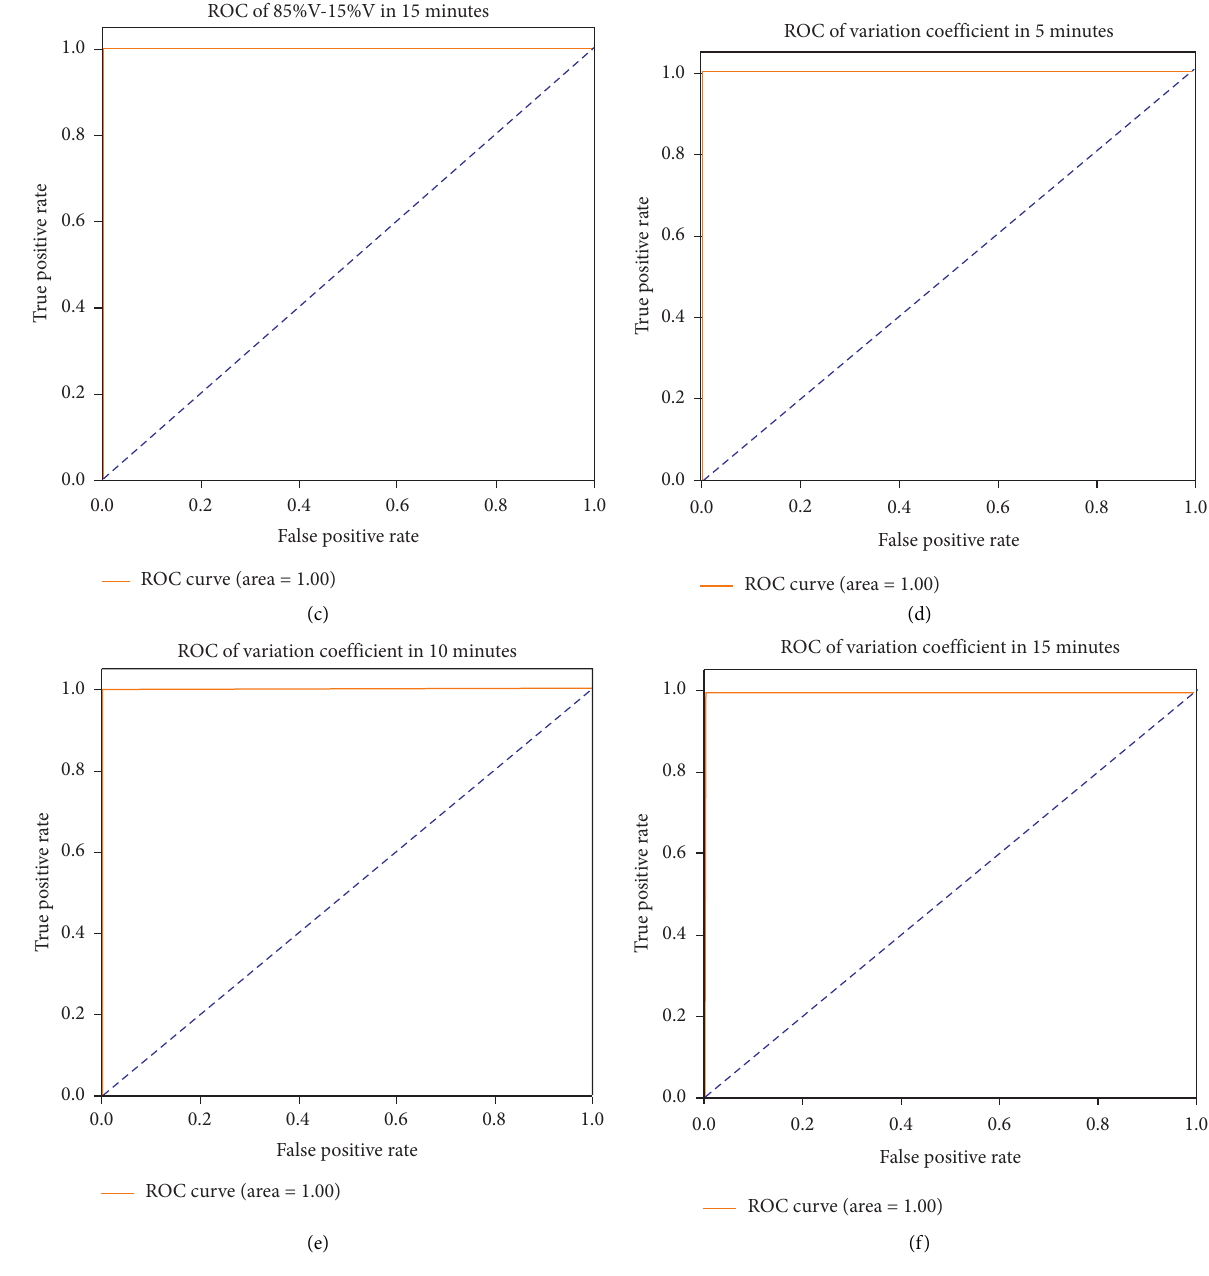
Figure 6: The ROC curve for SVM of 85%V–15%V and variation coefficient in different